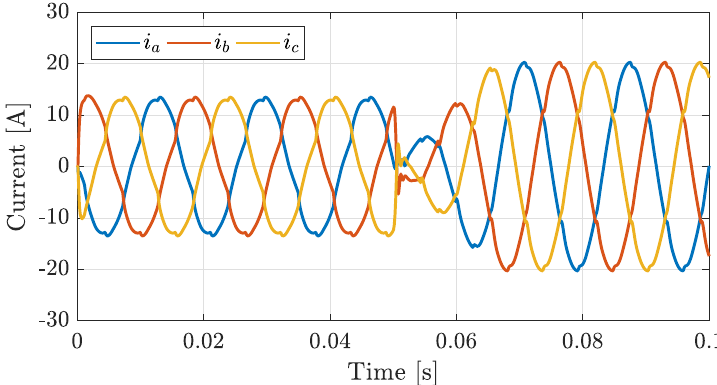
Figure 9. Current correction by the hybrid PI-LQR control action under balanced nonlinear load conditions.